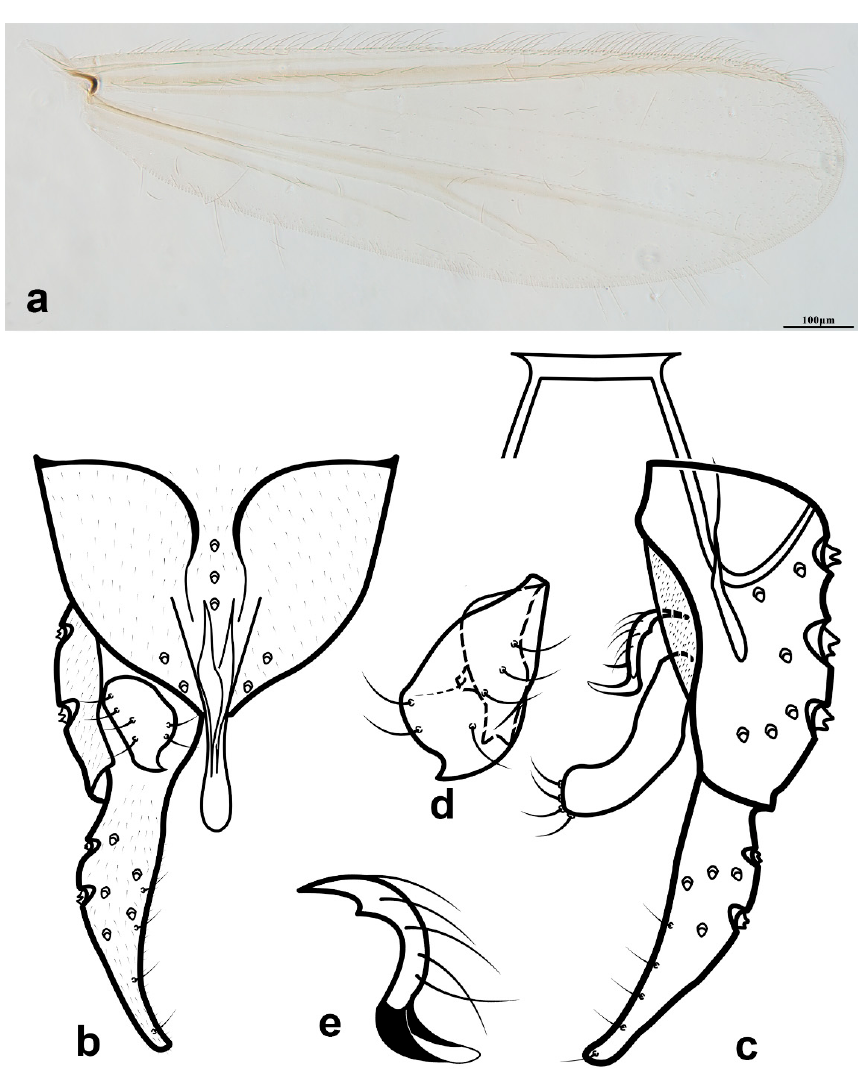
Figure 3. Rheotanytarsus falcipedius : ( a ) wing; ( b ) hypopygium, dorsal view; ( c ) hypopygium, ventral view; ( d ) superior volsella; ( e ) median volsella.